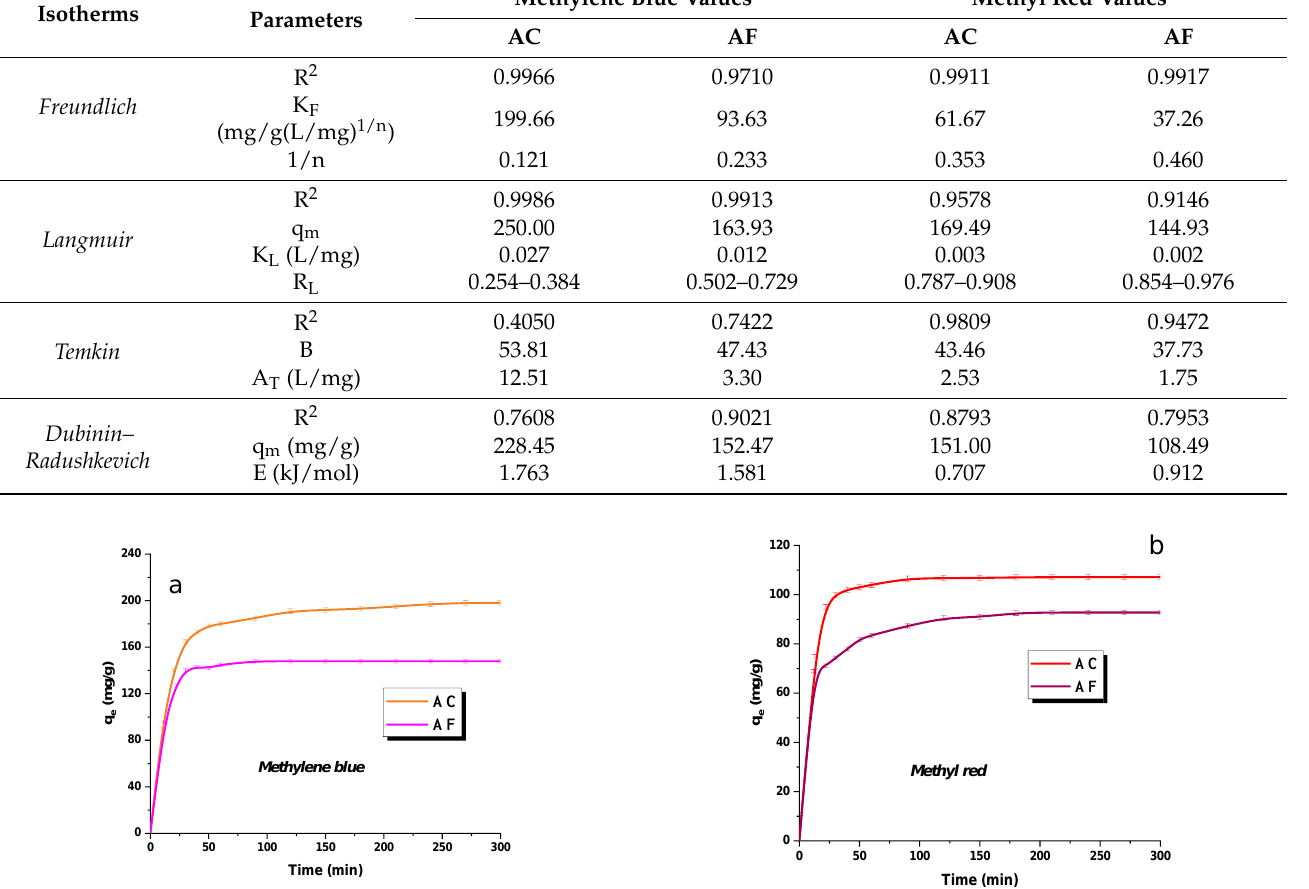
Figure 4. The effect of contact time of adsorbent with adsorbate on the adsorption of methylene blue ( a )/methyl red ( b ) on activated carbon samples.